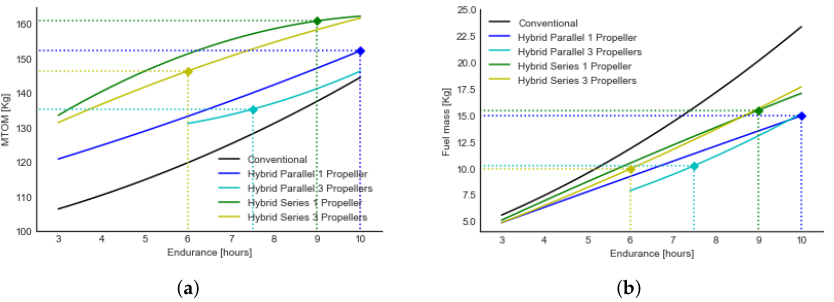
Figure 10. Comparison between series, parallel hybrid, and conventional propulsion configurations 600 m. ( a ) MTOM vs. Endurance; ( b ) Fuel Mass vs.